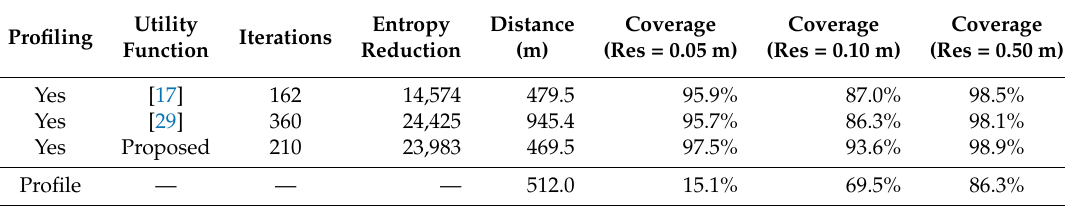
Table 3. Scenario 2 (power plant) final results showing coverage completeness by using the proposed utility function compared to the other